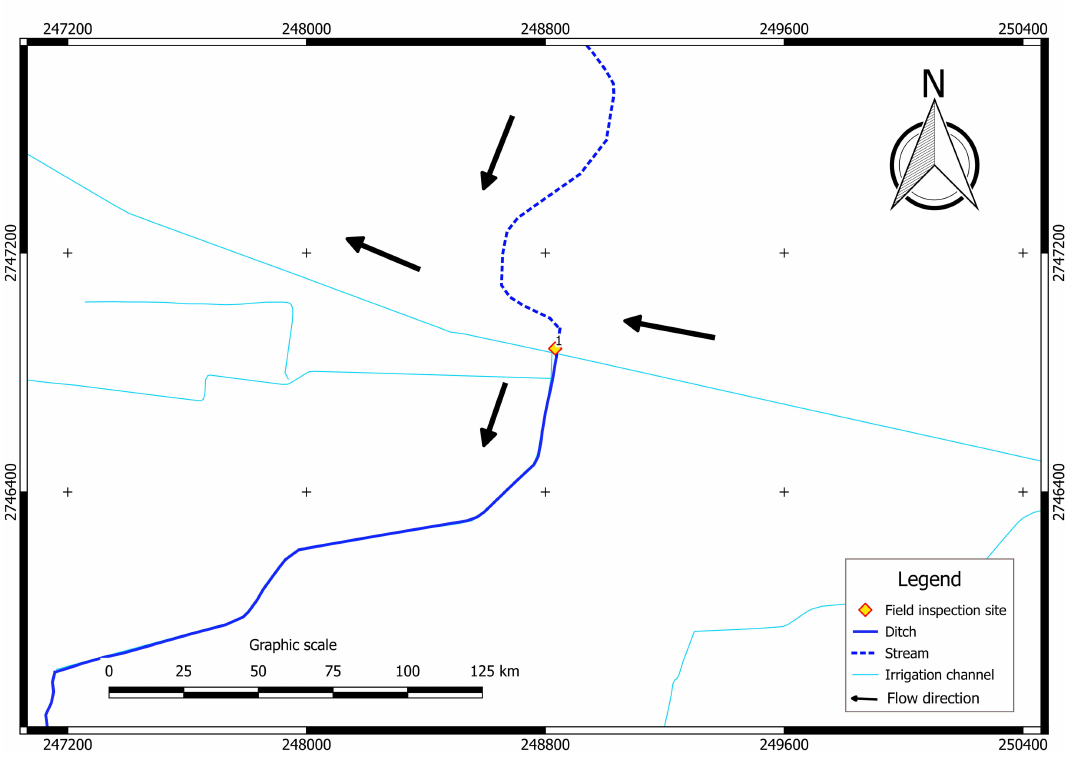
Figure 7. A stream drains to a channel in the study